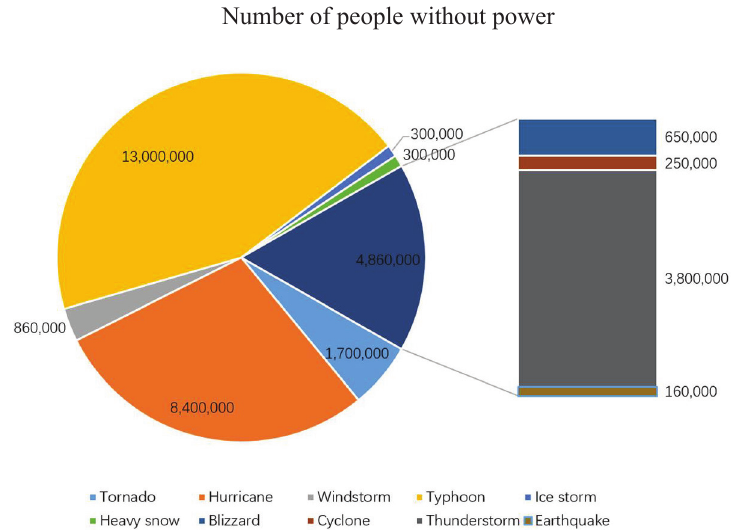
Figure 1. Pie chart of major power outages under extreme cases from